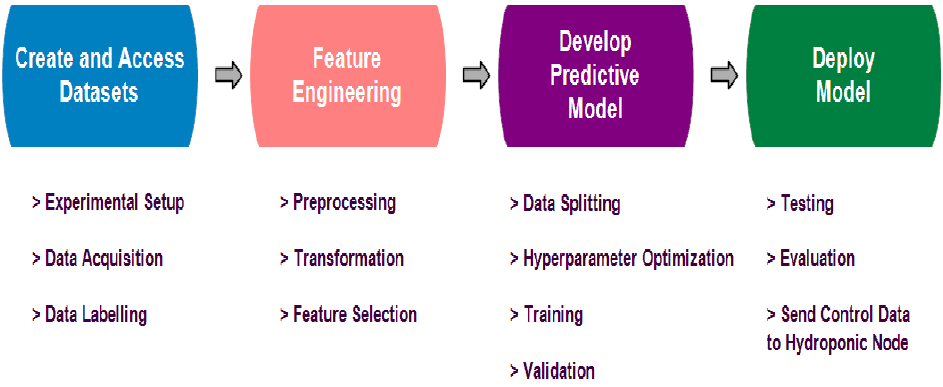
Figure 6. Implementation flow of data analytics system.